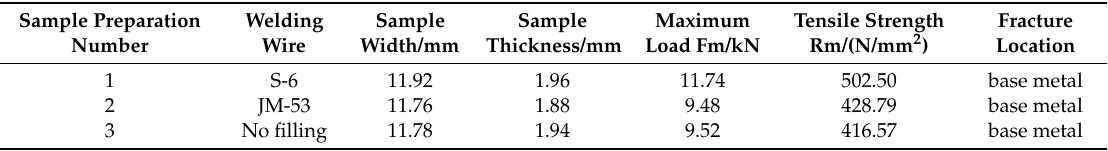
Table 8. Tensile test results of welded